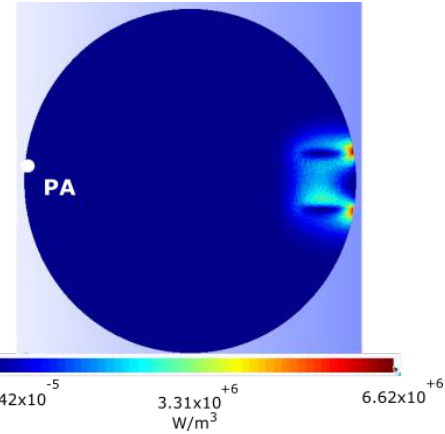
Figure 8. Distribution of volumetric density of the heat power in the disk, due to induced currents with w r = 11 rad/s and d = 5 mm, with a total heat power of 32.26 W.